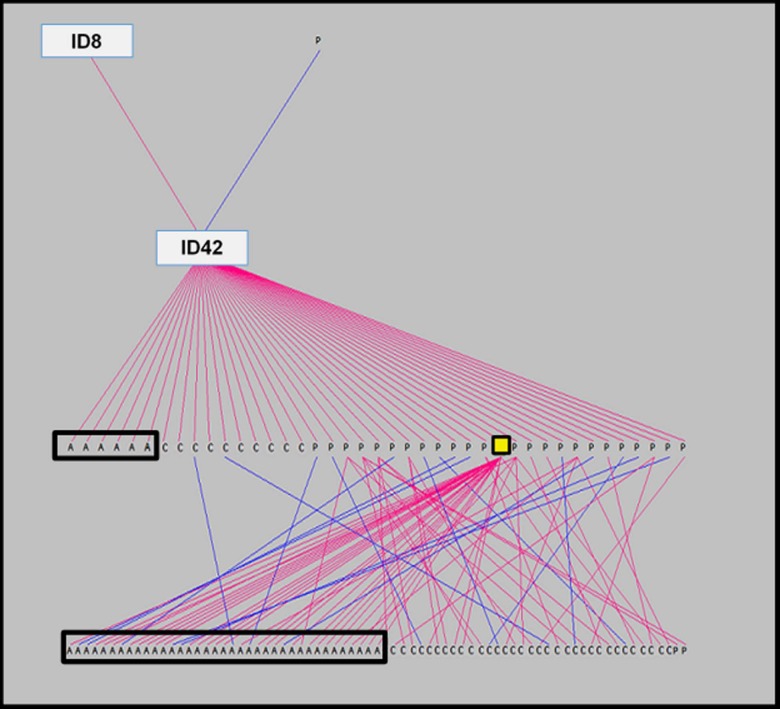
Sire line pedigree of ID1 (yellow square) depicting relatives, ancestors and descendants appearing as affected (A) or control (C) racehorses, or as ancestors in the pedigrees of other affected or control horses (P). Sire lines are presented in pink, with dam lines in blue.